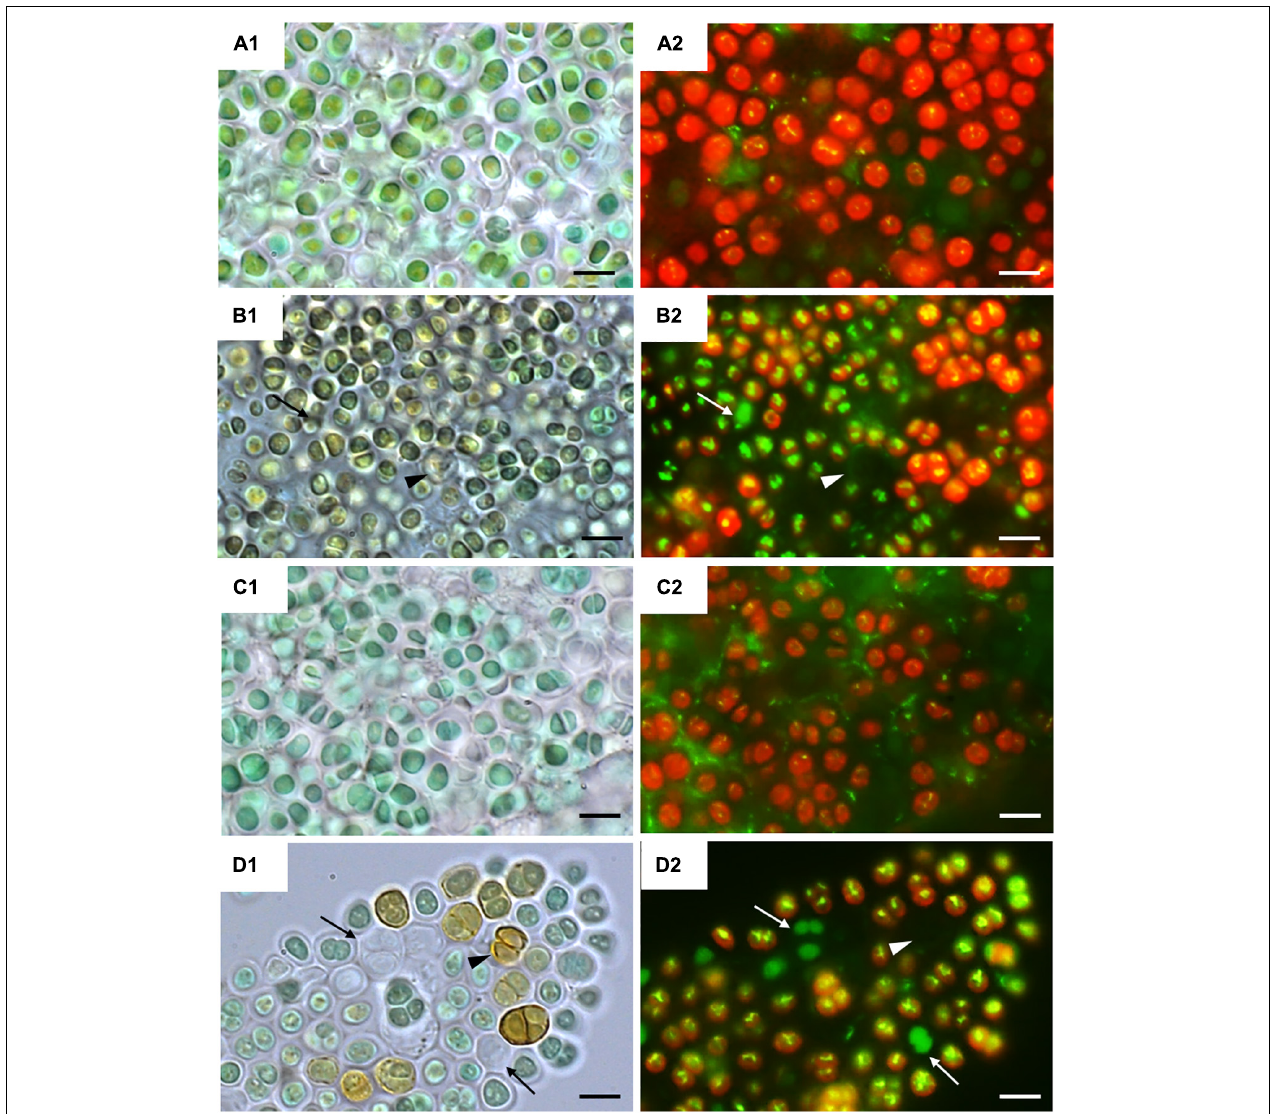
FIGURE 2 | CellROX staining for intracellular detection of ROS in UAM813 (Series A,B) and UAM816 (Series C,D) cells. Bright field (A1,C1) and fluorescence microscopy (A2, C2) images of Series A,C correspond to exposure time t = 0, and in Series B,D after 24 h of exposure to UVR + PAR. The red signal corresponds to cyanobacterial chlorophyll a and phycobiliproteins autofluorescence, which was stronger in PAR only exposed cells (A2,C2) than in UVR + PAR exposed cells (B2,D2) . Bright yellow/green dots in fluorescence images are CellROX fluorescence staining (oxidative stress indicator); thus, oxidative stress was greater in UVR + PAR exposed cells (B2,D2) than in PAR only exposed cells (A2,C2) . In images of UVR + PAR-treated cells, the arrows point to cells revealing apparent structural integrity (B1,D1) via the green autofluorescence signal, and no autofluorescence either CellROX fluorescence signal (B2,D2) and brown color (B1,D1) suggesting an increase in scytonemin content. Scale bars = 8 µ